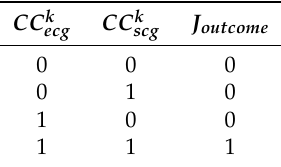
Table 3. Combined analysis outcomes of ECG and SCG cardiac